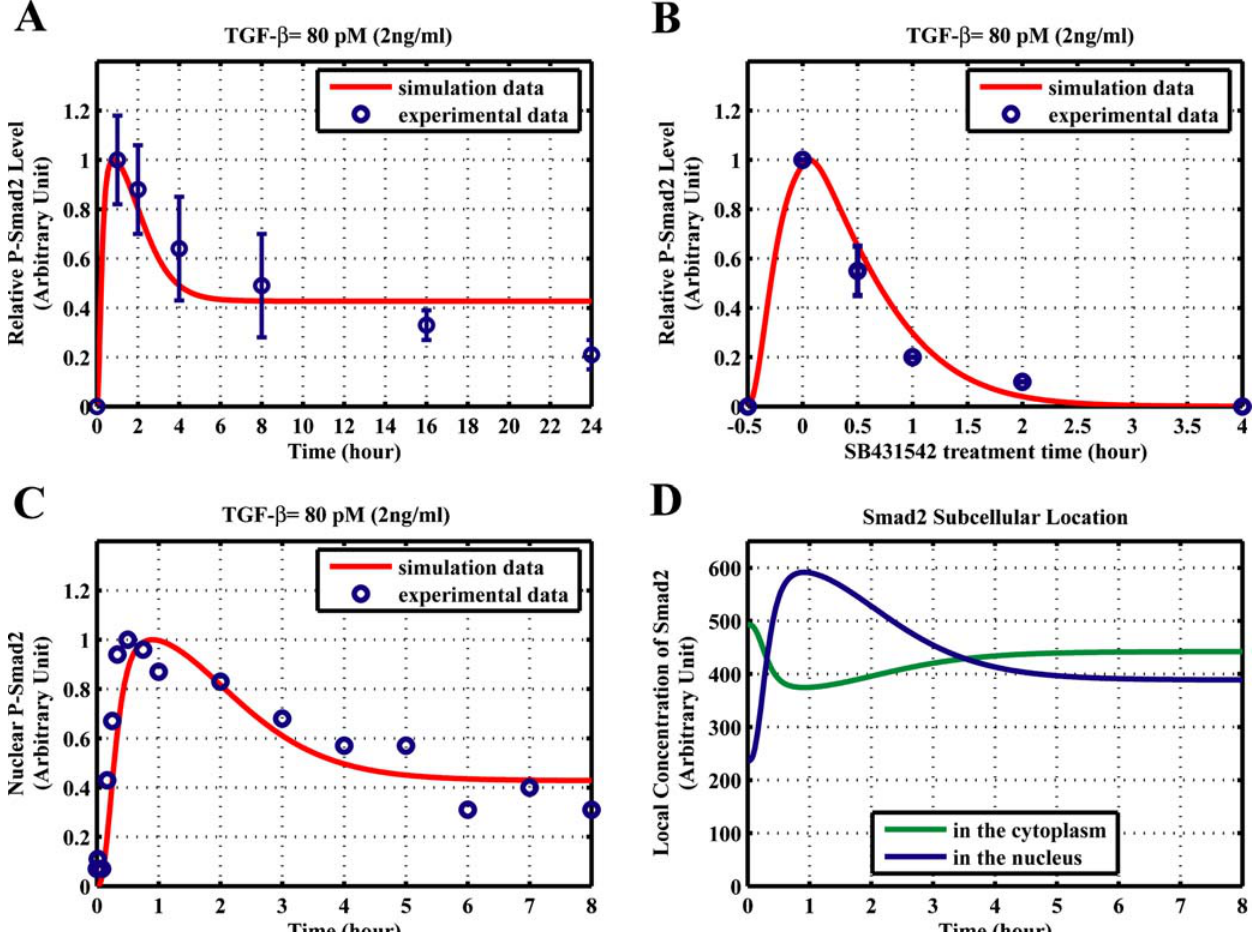
Figure 2. Comparison of experimental analysis and simulation results from the model obtained by constraint-based modeling method. (A–B) for ‘‘in-sample fit’’. (C–D) for ‘‘out-sample fit’’. (A) Comparison of the model time course and experimental time course of Smad2 phosphorylation with 24 hours TGF- b treatment. The experimental data is normalized from Figure 1A in Lin et al. [4]. (B) Effect of type I receptor kinase inhibitor SB431542. Cells were treated with TGF- b for 30 minutes, then were washed out TGF- b at 30th minute and added SB431542 to prevent rephosphorylation of Smad2. The experimental data is normalized from Figure 1C in Lin et al. [4]. (C) Comparison of the model time course with an experimental time course of nuclear phosphorylated Smad2 after TGF- b treatment (80 pM, 2 ng/ml). The western-blot data reported by Inman et al. (Fig. 1A, top panel) is quantified with Scion Image software [29]. (D) Subcellular location of Smad2 after TGF- b treatment (80 pM). The concentrations shown here refer to the local concentrations in cytoplasm and